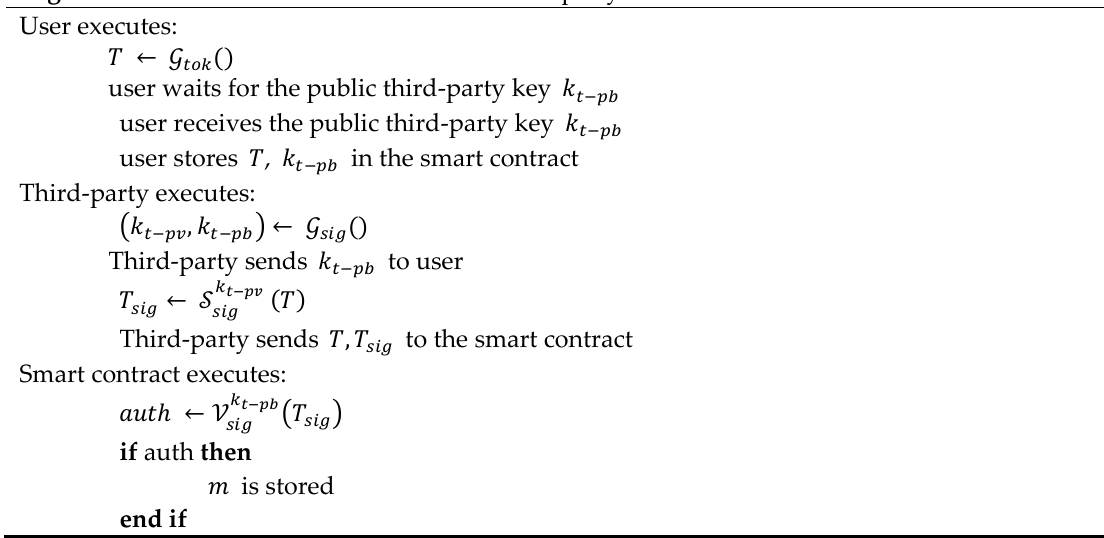
Algorithm 2 Authorization mechanism for